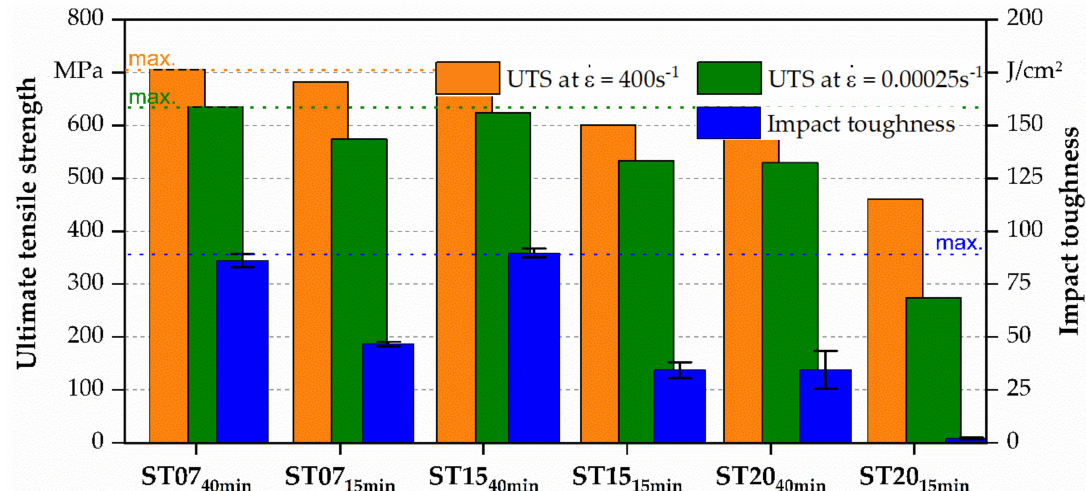
Figure 18. Comparison of the results of the low-strain-rate tensile tests, high-strain-rate tensile tests, and impact toughness tests for ST07, ST15, and ST20 for both brazing